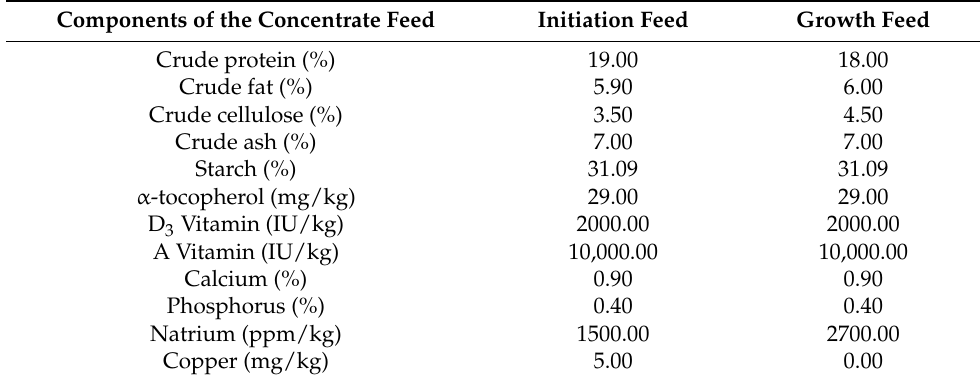
Table 1. Chemical composition of the concentrate